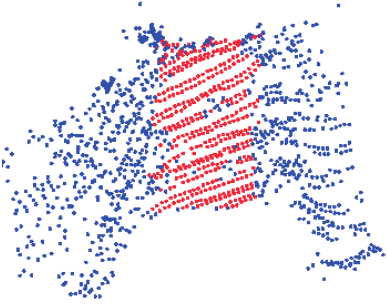
Figure 18. Results of the road surface